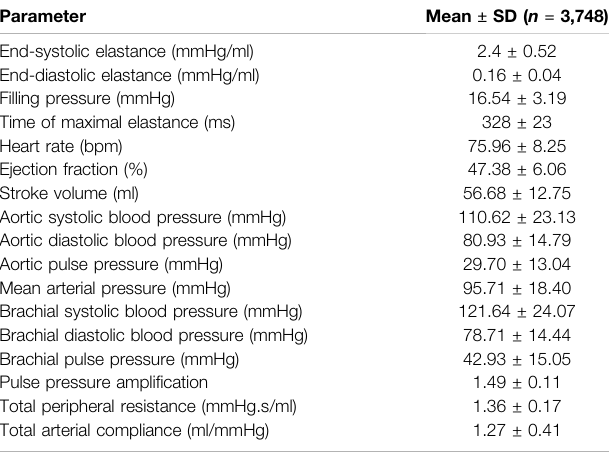
TABLE 4 | Cardiovascular characteristics of the virtual study cohort ( n (cid:1) 3,748). Parameter